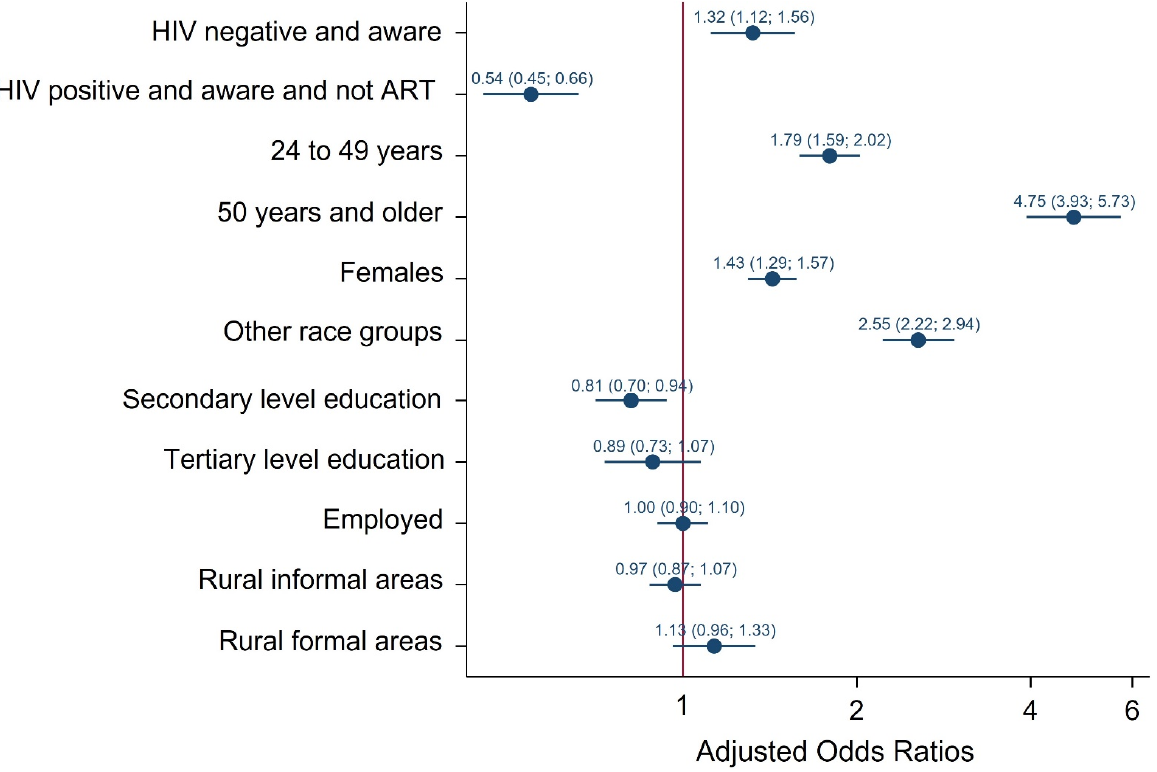
Figure 2. Multivariate logistic model of factors associated with not using a condom during their last sexual encounter among individuals 15 years older, South Africa 2017 survey.